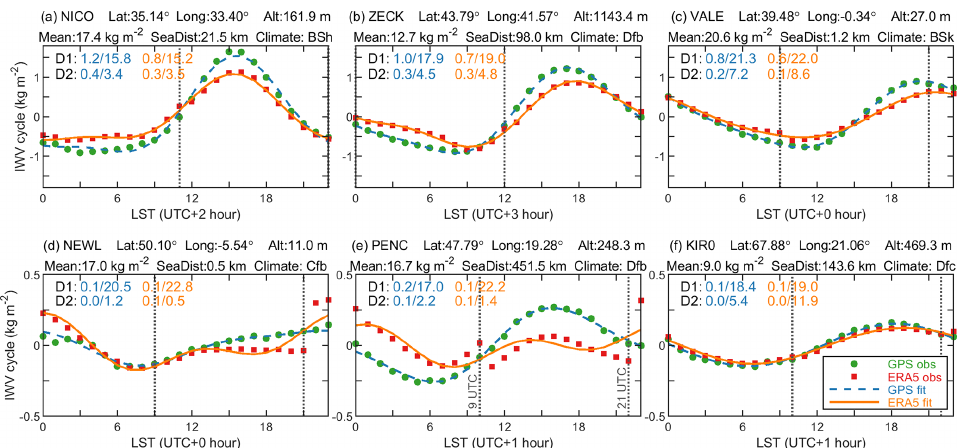
Figure 8. Diurnal IWV cycles at selected six stations obtained from 1-hourly GPS (green dots) and ERA5 (red squares). The stations are selected with the consideration of different altitudes, distance to sea (SeaDist), and climate zones classified according to the Köppen climate classification system (Beck et al., 2018). The data points are fitted with diurnal ( D 1 ) and semidiurnal ( D 2 ) harmonics (dashed blue curve for GPS and orange curve for ERA5). The amplitudes and phases of the D 1 and D 2 harmonics are also given. The phases are shown as the local solar time (LST) at the peak of associated harmonics. For instance, the D 1 amplitude and phase of GPS IWV at station NICO are 1.2kgm − 2 and 15.8LST, respectively. By comparison, the values of its ERA5 IWV are 0.8kgm − 2 and 15.2LST, respectively. The vertical dotted black lines at 09:00 and 12:00UTC indicate the time of possible mismatches in the ERA5 IWV cycle.